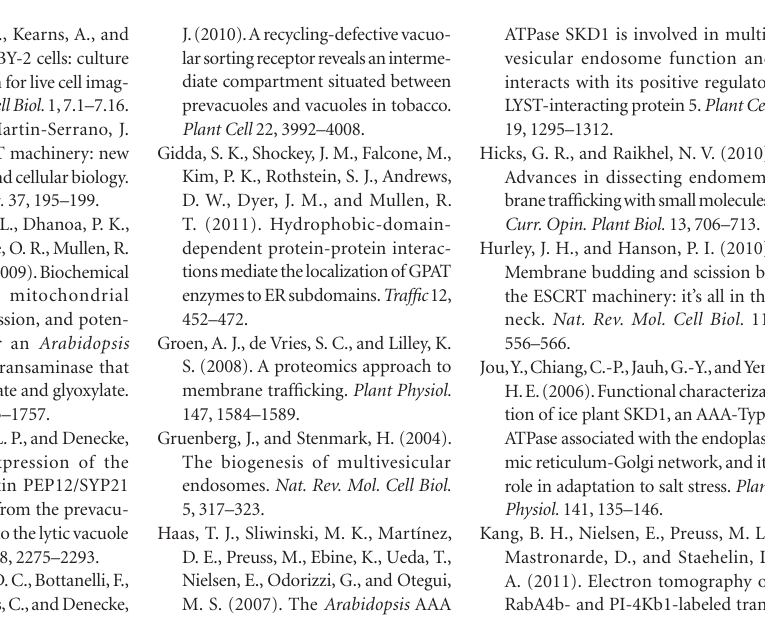
FIGuRE S1 | Protein immunoblot analysis of yeast expressing individual AD- or BD- Arabidopsis ESCRT fusion proteins. Yeast were transformed individually with plasmids encoding either (A) GAL4‑AD or (B) GAL4‑BD ESCRT fusion proteins or the corresponding “empty” AD or BD control plasmids, were cultured in non‑selective media and then processed for SDS‑PAGE and immunoblotting (see Materials and Methods for details). Shown are representative immunoblots probed with either (A) α ‑Myc antibodies, which recognize the Myc‑epitope tag located between the GAL4‑AD moiety and